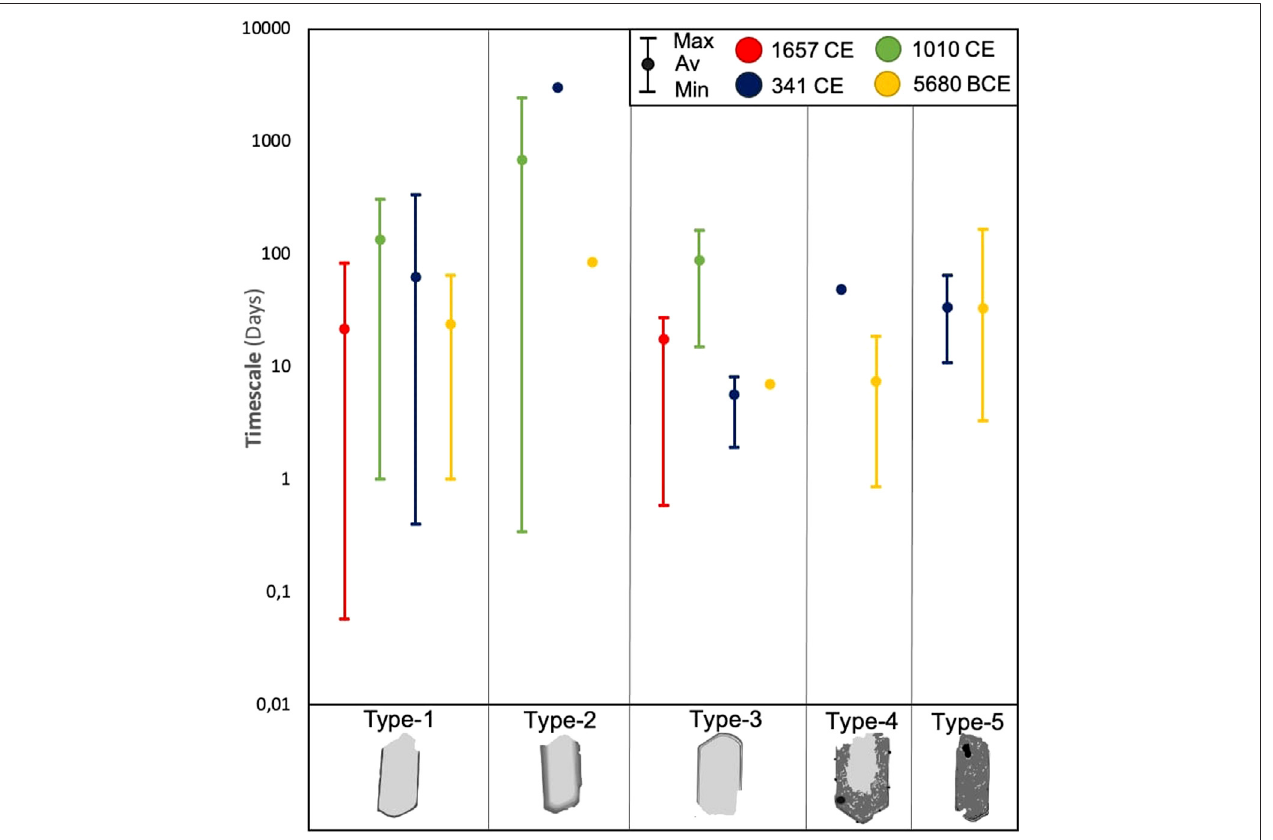
FIGURE 12 | Maximum, minimum and average timescale values for the different crystal populations recorded in each eruption. For single points, only one crystal wasidenti fi ed. Thelargestrange ofvaluesareobservedinthesimplecrystalsType-1 andType-2; however,thismaybeare fl ection ofpopulationsize.Type-1 isfoundin all eruptions and records the shortest timescales. Type-2, is mainly found in the 10101 Cal. CE eruption and records the longest timescales and a large range of timescales. Type-3 hasthe fewest number ofcrystalsand shows the smallest range ofvalues. While the 1657Cal. CE, ∼ 341Cal. CE and 5680 Cal. BCE eruptions show similar averages, the 1010 Cal. CE eruption shows a higher average and minimal overlaps with the other eruptions.